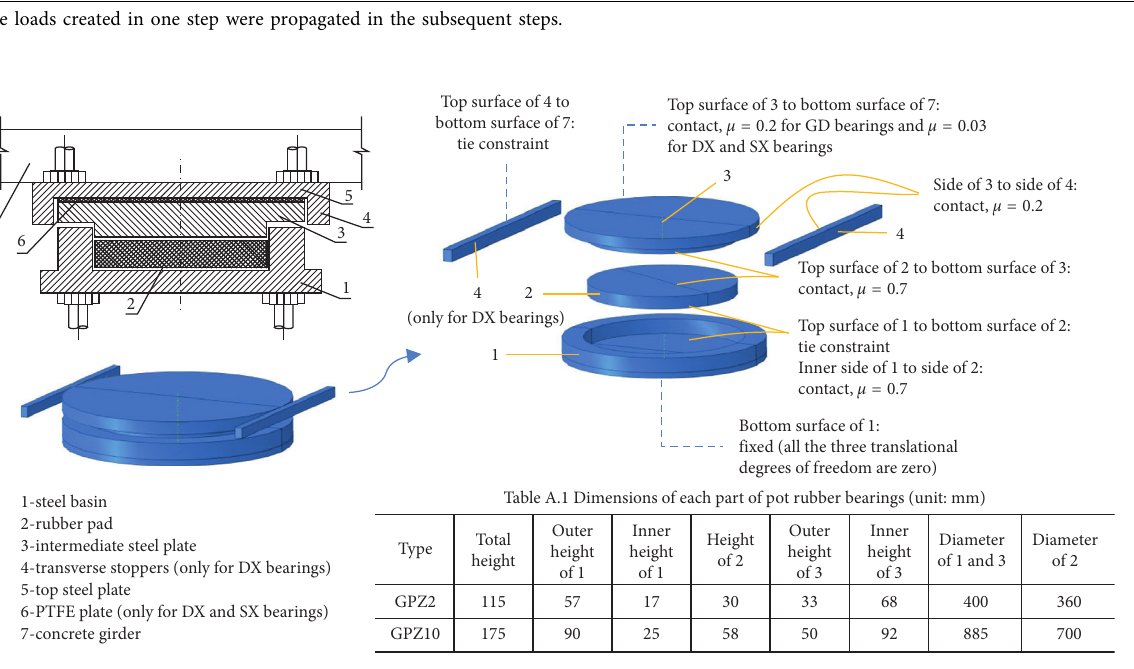
Table 1: Loading procedures in the models.